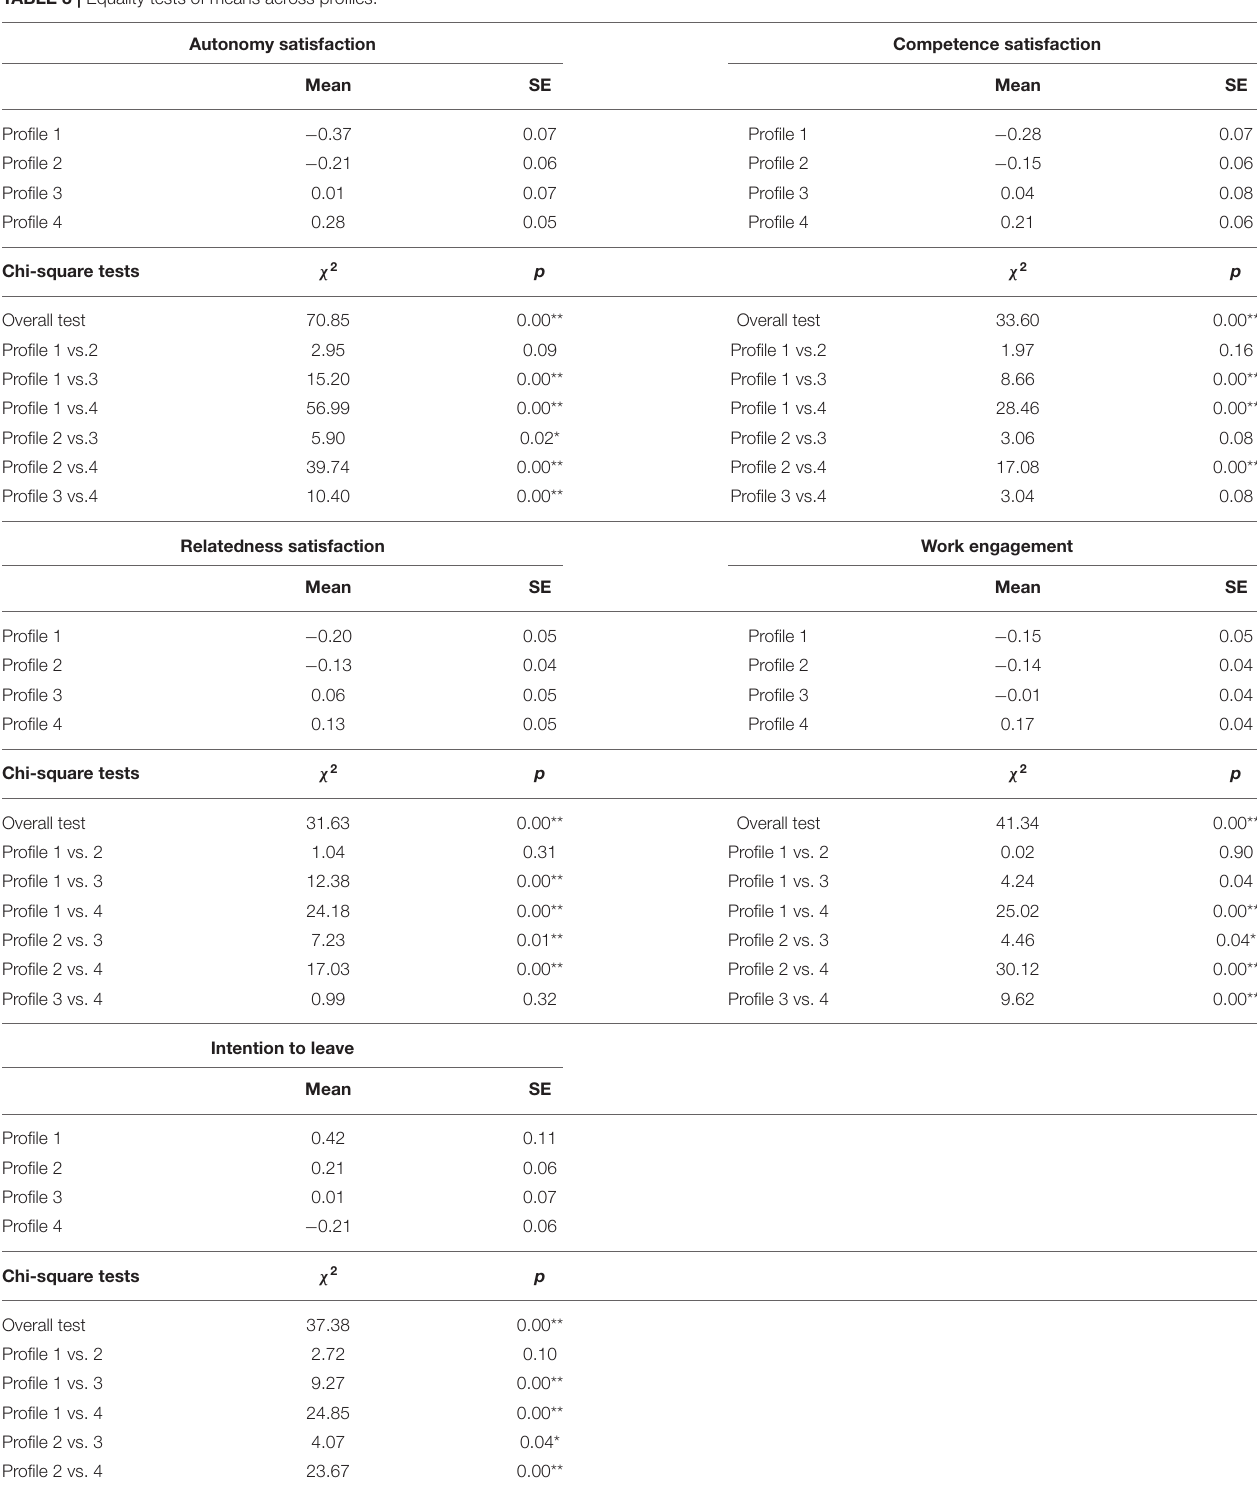
TABLE 3 | Equality tests of means across